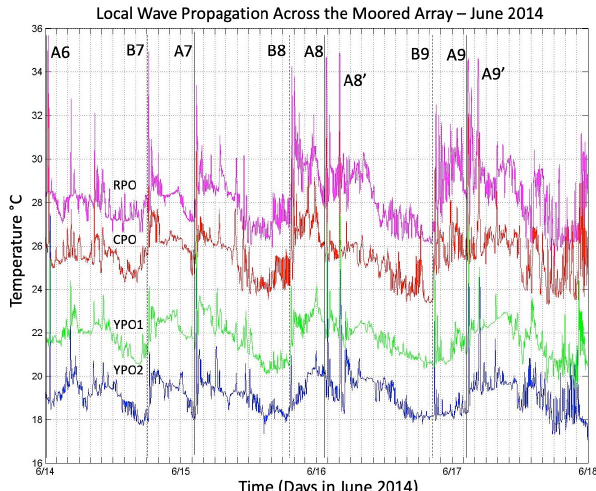
Figure 5. Temperature vs. time during 2–6 June at all four moor- ings across the continental slope. The observations are from 75, 79, 97, and 99m from moorings RPO, CPO, YPO1, and YPO2 respec- tively. Each time series has been offset vertically by 2 ◦ C for clarity. The black ellipses highlight the region of strong temperature fronts at CPO that subsequently broke and formed b waves at RPO.